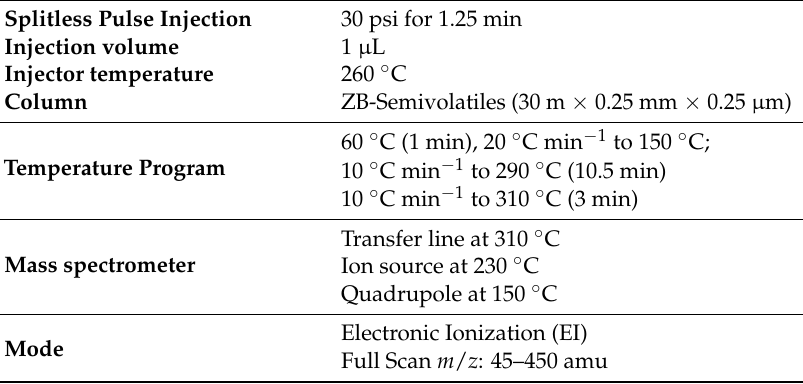
Table 1. Gas chromatography-mass spectrometry (GC-MS) analytical